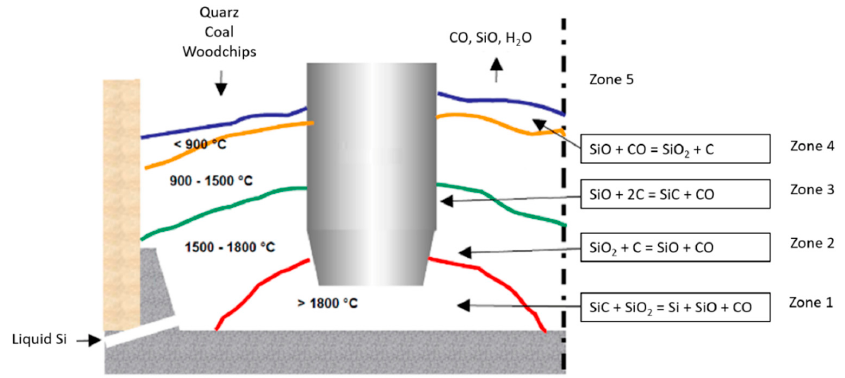
Figure 5. Picture of the upper part (zone 5, Figure 6) of a submerged ARC electrode furnace during process showing two electrodes in the center of the picture.